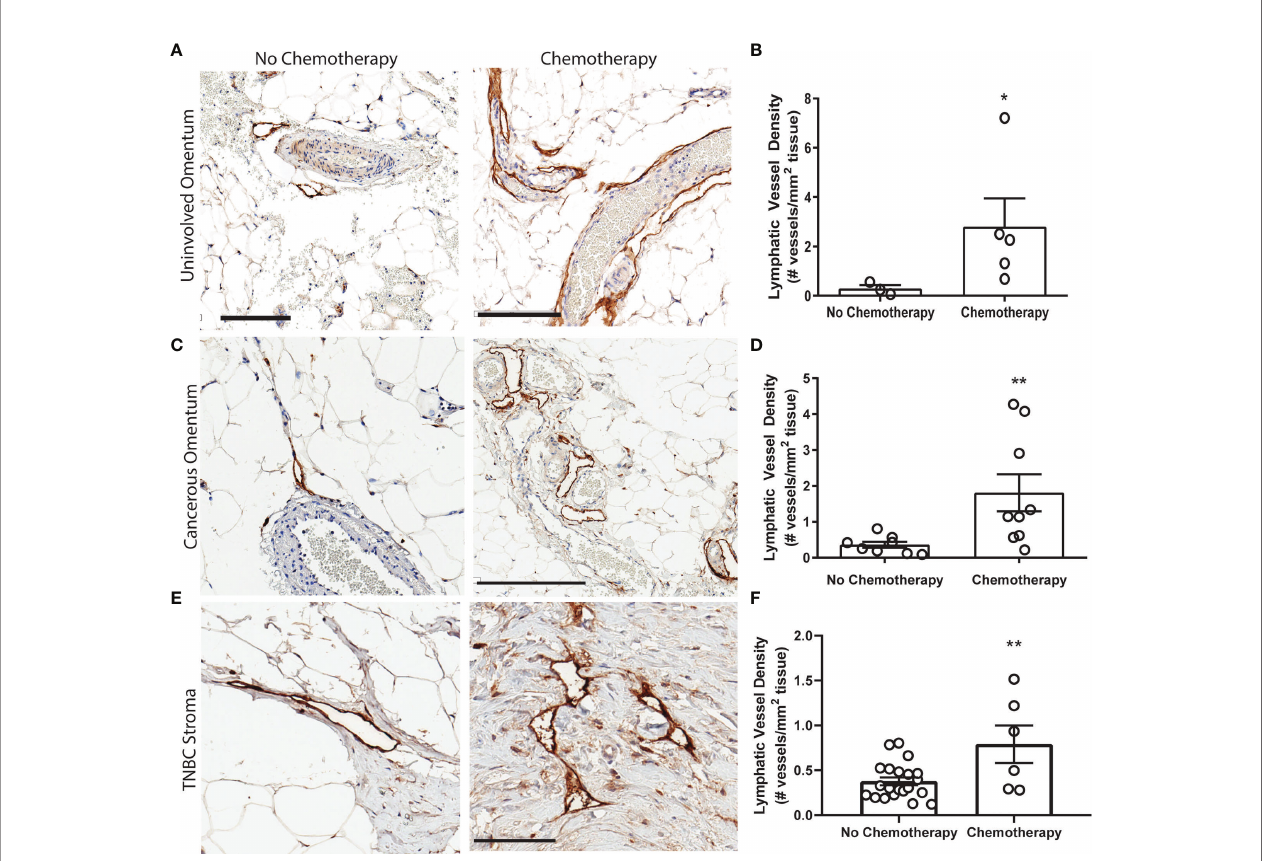
FIGURE 3 | Platinum chemotherapy is associated with higher LVD in human cancer patients (A) Representative images of lymphatic vessels in histologically benign omentum from patients treated with no chemotherapy (left) or neoadjuvant carboplatin combination chemotherapy (right) ( see Table S4 ) with podoplanin (brown) and hematoxylin (blue). (B) Quanti fi ed lymphatic vessel density in patient samples. Scale bar = 200 µms. N=8 patients. (C) Representative images of tissues from ovarian cancer patients treated with no chemotherapy ( left ) or neoadjuvant carboplatin and paclitaxel ( right ) in cancerous omentum with podoplanin(brown) and hematoxylin (blue). (D) Quanti fi ed lymphatic vessel density (N= 17). (E) Representative images of tissues from triple negative breast cancer patients treated with no chemotherapy ( left ) or neoadjuvant platinum and taxane ( right ) with podoplanin(brown) and hematoxylin(blue). (F) Quanti fi ed lymphatic vessel density (N=27) *p < 0.05, **p < 0.01, scale bar = 200µm. Each data point represents one